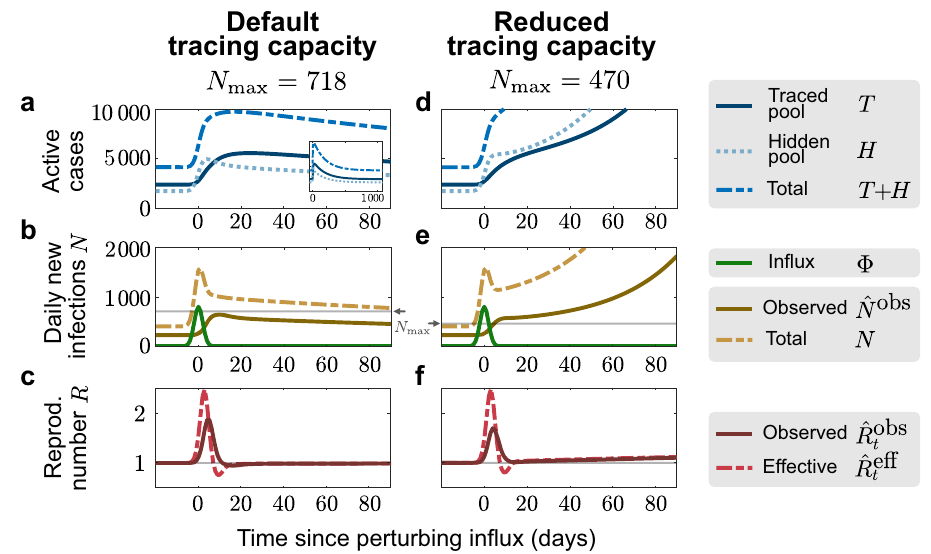
Fig. 3 Finite tracing capacity makes the system vulnerable to large in fl ux events. A single large in fl ux event (a total of 4000 hidden cases with 92% occurring in the 7 days around t = 0, normally distributed with standard deviation σ = 2 days) drives a metastable system with reduced tracing capacity ¼ 470) to a new outbreak ( d – f ), whereas a metastable system with our default tracing capacity (reached at N ¼ 718) can compensate (reached at N max max a sudden in fl ux of this size ( a – c ). a , d The number of infections in the hidden pool (dotted) jump due to the in fl ux event at t = 0, and return to stability for default capacity ( a ) or continue to grow in the system with reduced capacity ( d ). Correspondingly, the number of cases in the traced pool (solid line) either slowly increases after the event and absorbs most infections before returning to stability (inset in a , time axis prolonged to 1000 days), or proceeds to grow steeply ( d ). b , e The absolute number of new infections (dashed, yellow) jumps due to the large in fl ux event (solid green line). The number of daily observed cases (solid brown line) slowly increases after the event, and relaxes back to baseline ( a ), or increases fast upon exceeding the maximum number of new observed cases N max (solid gray line) for which tracing is effective. c , f The effective (dashed red line) and observed (solid dark red line) reproduction numbers change transiently due to the in fl ux event before returning to 1 for the default tracing capacity. In the case of a reduced tracing capacity and a new outbreak, they slowly begin to grow afterward ( f ). All the curves plotted are obtained from numerical integration of Eqs. (1) – (5).